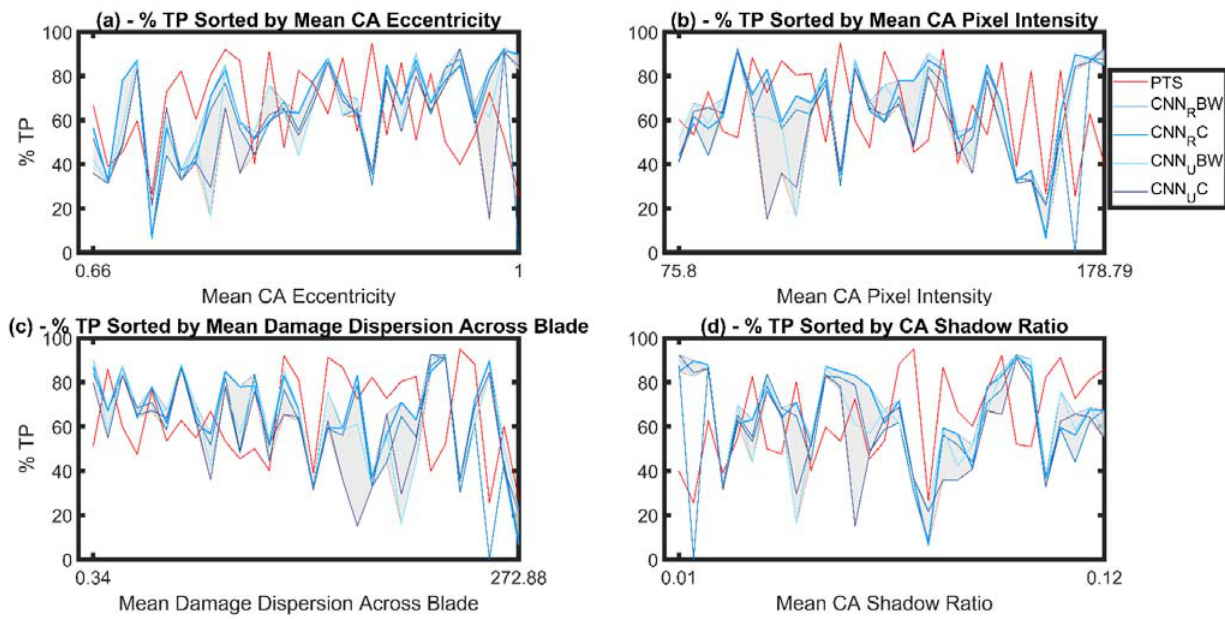
Figure 14. Damage quantification results for unsupervised (PTS) and supervised (CNN) models, shown as the percent of pixels accurately identified as damage when compared to subjective identification (% true positive (TP)). For each panel, quantification results are sorted in ascending order in terms of per-image mean ( a ) CA eccentricity, ( b ) CA pixel intensity, ( c ) damage dispersion across the blade, and ( d ) CA shadow ratio. Gray shading is applied to show the dispersion between CNN % TP values for each image. The gray shading shows the dispersion in the CNN results (maximum and minimum CNN results for each panel, i.e. b, c, and d, are used as the boundaries for the gray shading).